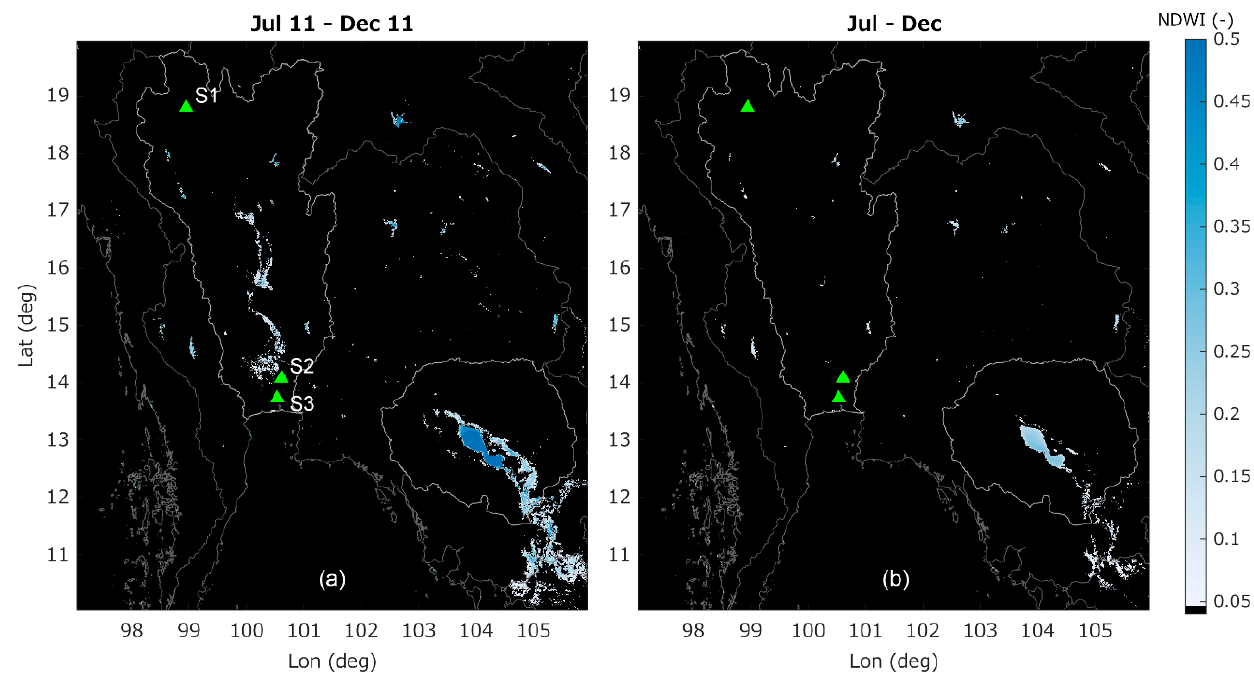
Figure 5. The averaged Moderate Resolution Imaging Spectroradiometer (MODIS)-derived normalized difference water index (NDWI) during the monsoon season, July–December. (Left; a ) The averaged NDWI during the flooding in 2011, July–December 2011. (Right; b ) The averaged NDWI of all July–December data between 2002 and 2018. For visualization, the NDWI < 0.05 are shown in black. The evaluation sites (S1–S3) are shown as green triangles (see the site’s name in ( a )).